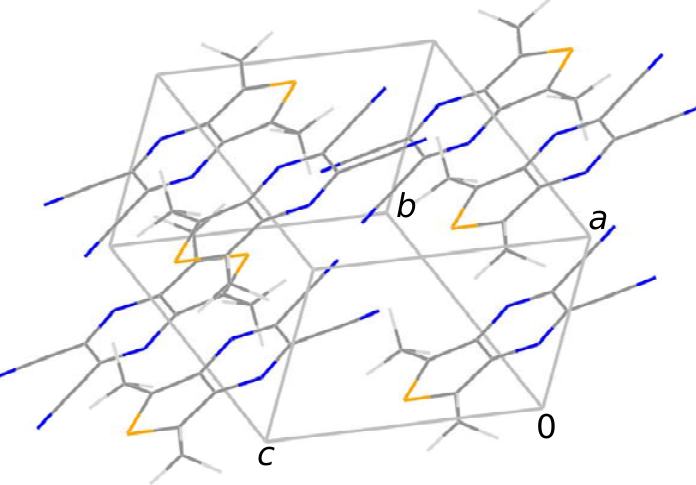
Figure 2. Crystal structure showing the arrangement of planar molecules in stacks with alternating orientation along b . Within each stack there is strong intermolecular interaction. Colour code: S: orange, N: blue, C: grey, H: light